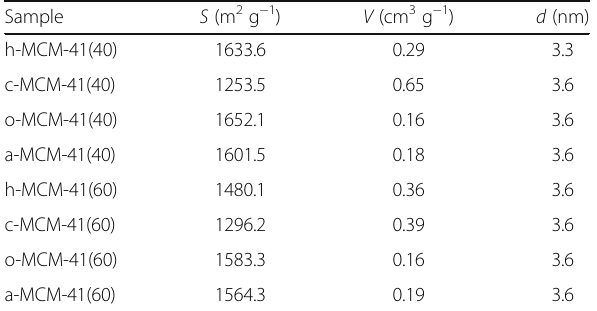
Table 1 Textural properties of the samples prepared with microwave heating